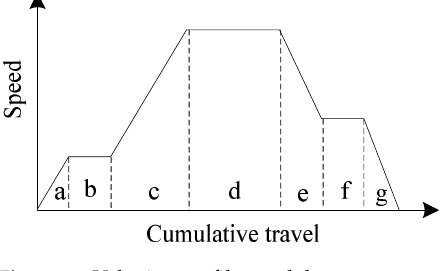
Figure 2. Velocity profile model.